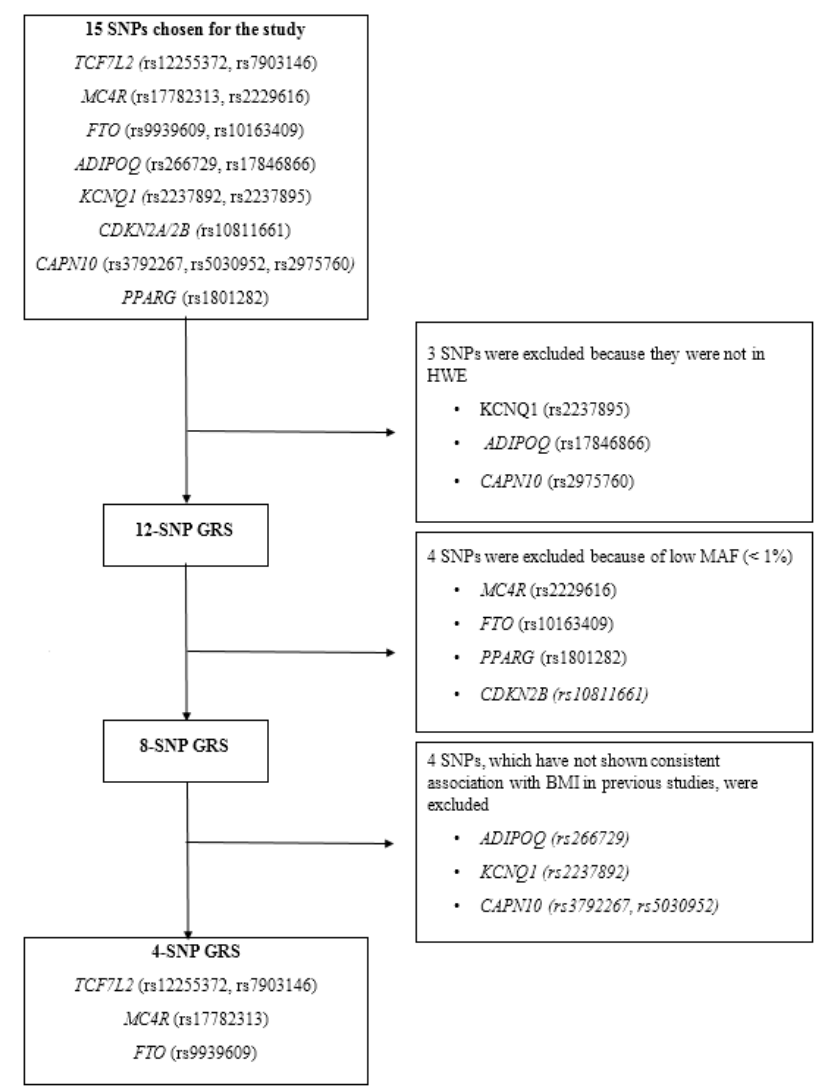
Figure 1. Steps involved in the construction of the metabolic GRS. Fifteen SNPs were genotyped in our study; however, the GRS analysis was based only on 12 SNPs as 3 SNPs were not in the HWE. Three different GRSs, including the 12-SNP GRS, 8-SNP GRS and the 4-SNP GRS were constructed. In the 12-SNP GRS analysis, no significant results were identified, which could be because 4 of the SNPs had MAF of less than 5%. Therefore, the 4 SNPs were excluded, and an 8-SNP GRS was created. No significant findings were observed using the 8-SNP GRS; this could be because four of the eight SNPs have not shown a consistent association with obesity-related traits in other populations. Hence, these four SNPs were removed and a 4-SNP GRS including those SNPs that have shown consistent associations with obesity across several populations was constructed. Abbreviations: SNP: single nucleotide polymorphisms; GRS: genetic risk score; HWE: Hardy–Weinberg equilibrium; MAF: minor allele frequency.